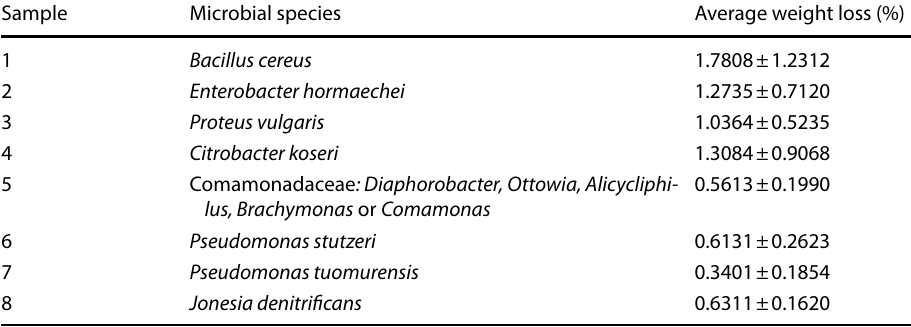
Table 3 Average HDPE dry weight loss during biodegradation assay